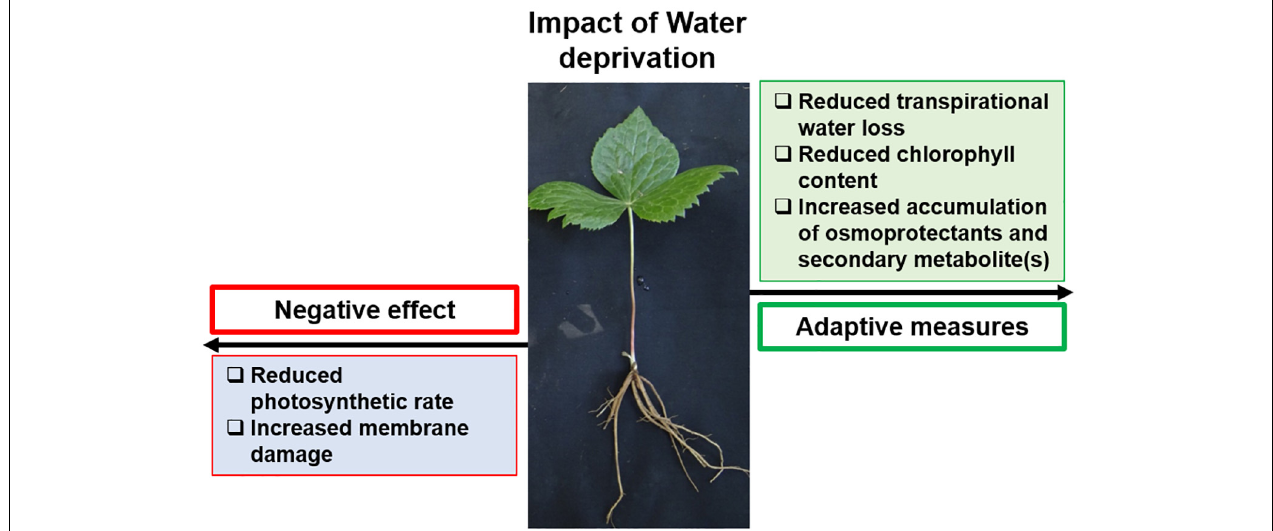
FIGURE 8 | S. hexandrum implements an adaptive strategy to sustain under water deficit conditions. Water deprivation reduces soil moisture content and water availability to plants, and induces membrane damage and cell death. To counter this, S. hexandrum plants prevent excess transpirational water loss; however, this negatively impacts photosynthetic rate. In response, plants accumulate less chlorophyll, avoiding unnecessary light-harvesting and ROS generation. Besides, osmoprotectants, such as proline and free sugars, accumulate along with the secondary metabolite, PTOX, which helps the plants to sustain under non-permissive